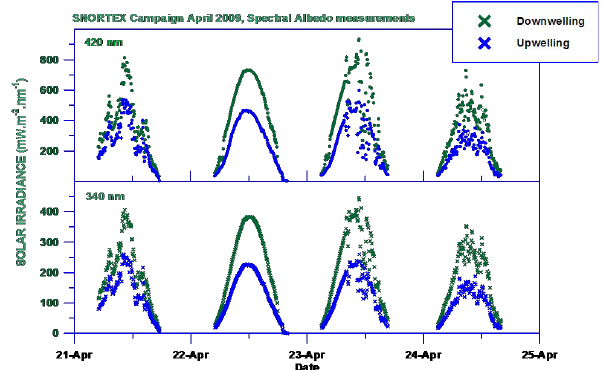
Fig. 2. Global downwelling and upwelling irradiance for 340nm and 440nm during the